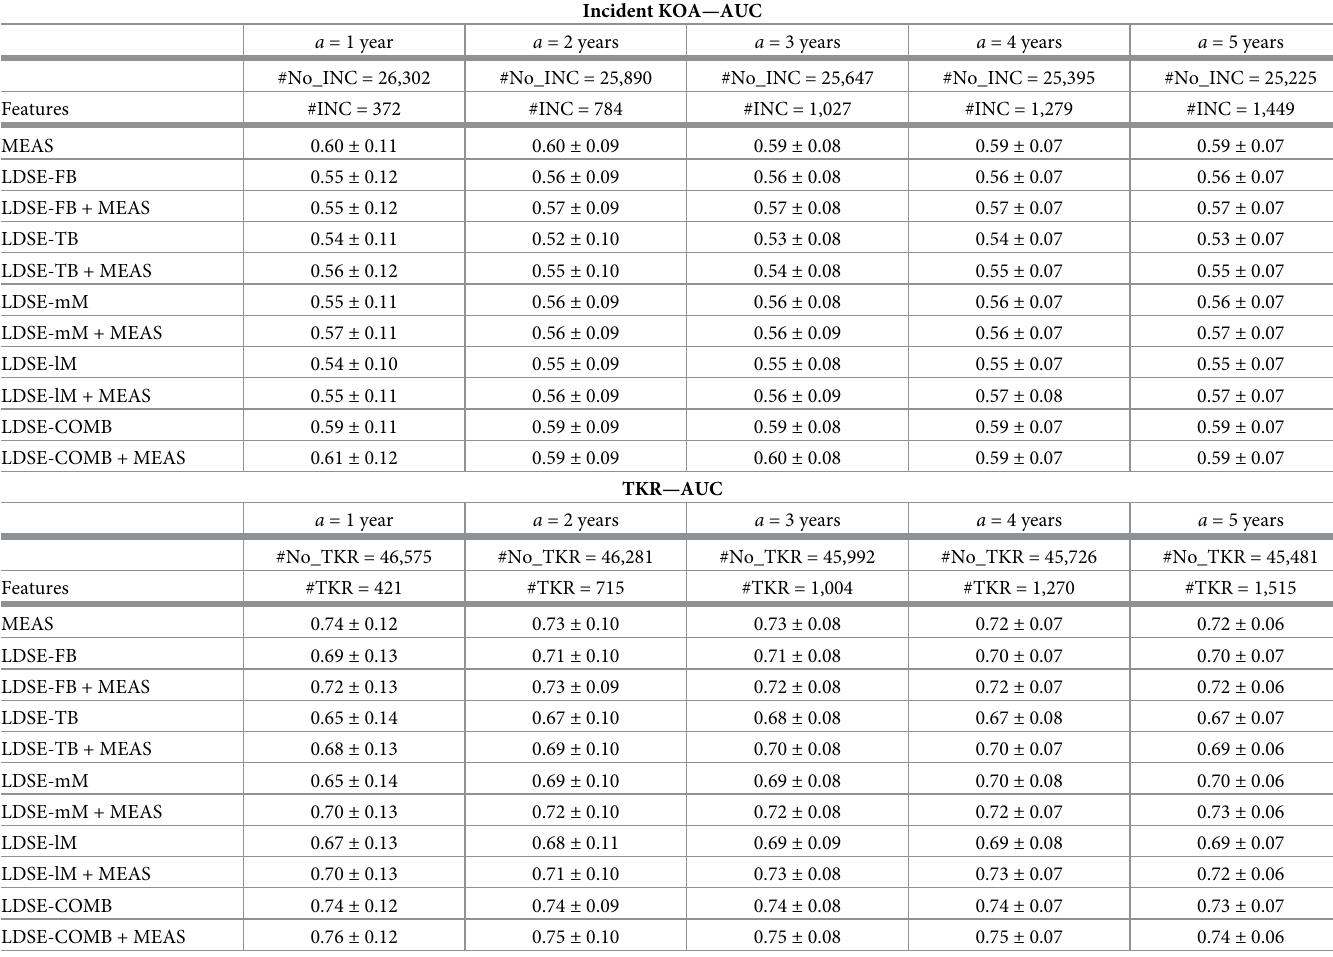
Table 5. Prediction of incident KOA (KLG > = 2 with JSN) and TKR surgery within a years. In both investigations the AUC is evaluated utilizing the respective true positive rate as well as the false positive